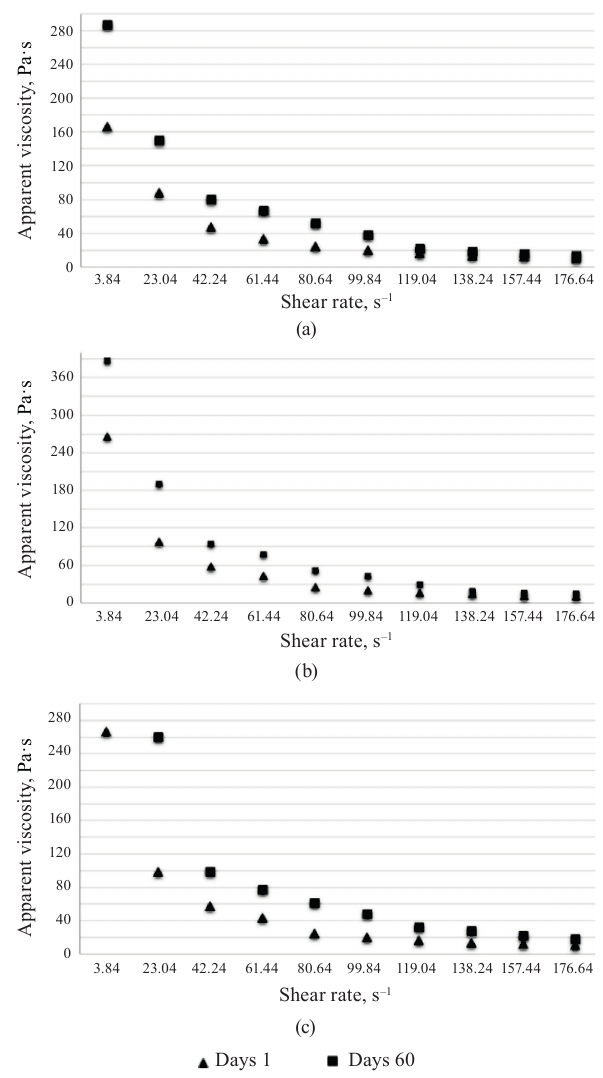
(b) Figure 4 Apparent viscosity of the kashk samples during storage: (a) control; (b) GCE 1%; and (c) EGCE 5%